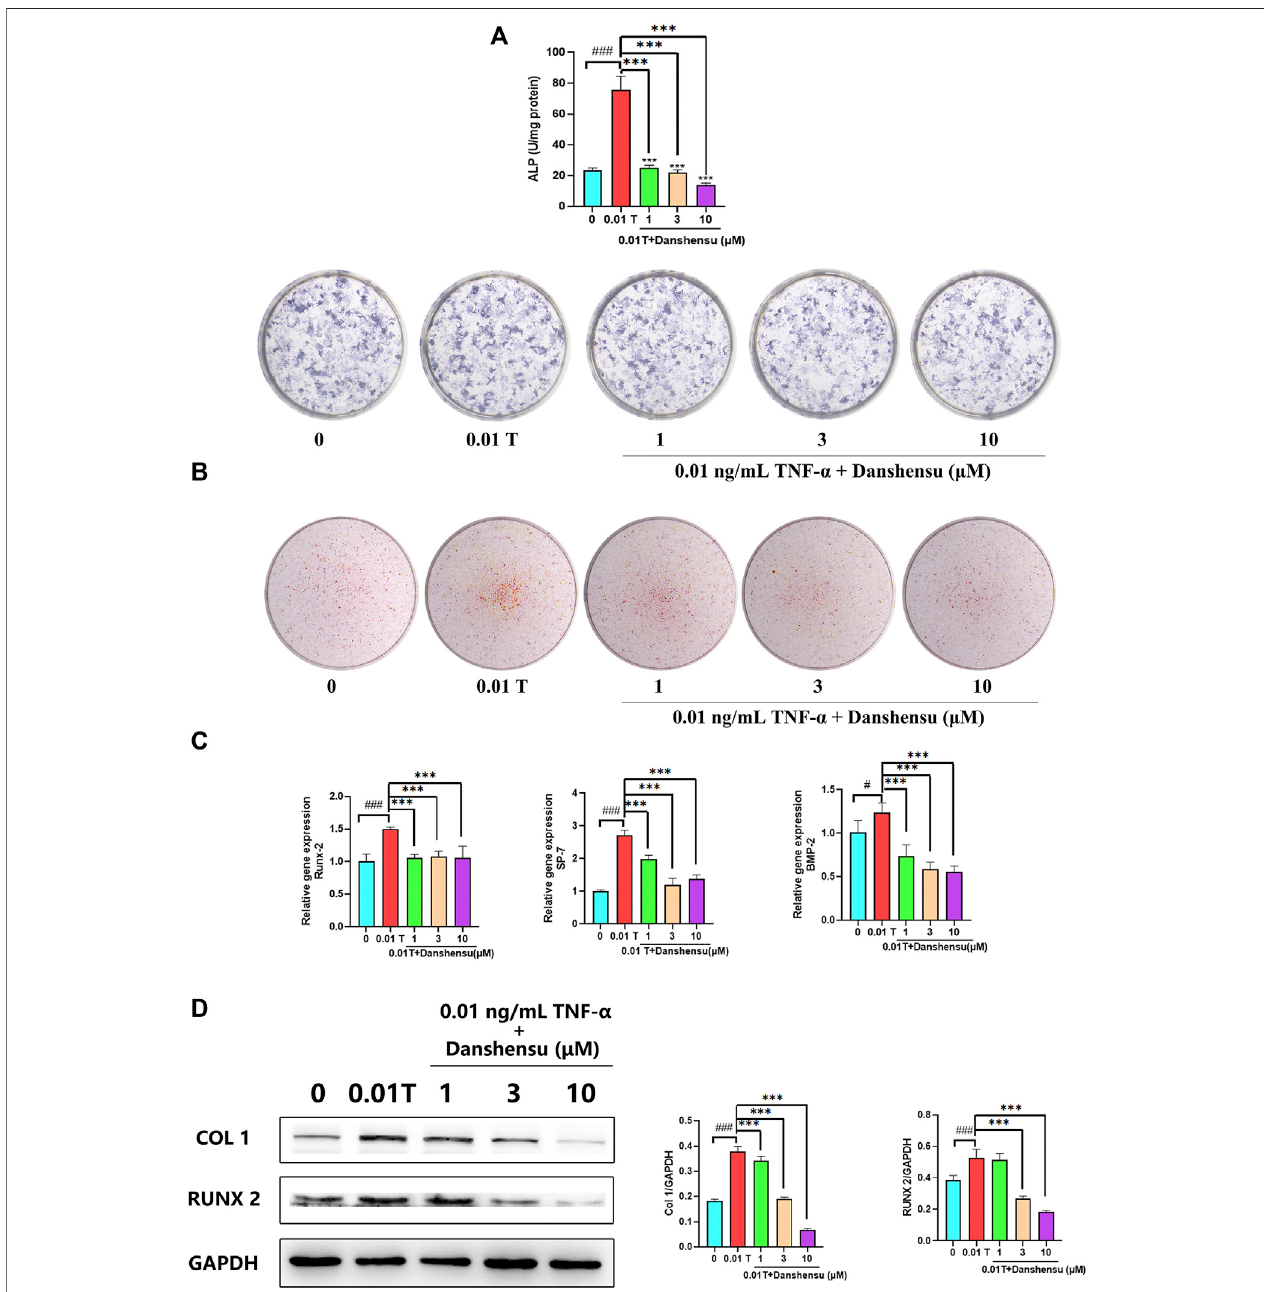
FIGURE7| DanshensuinhibitsTNF- α – inducedosteogenicdifferentiation. (A) ALPactivityandstainingofosteoblastsafter7 daysoftreatmentwithTNF- α . (B) ARS of osteoblasts at days 30. (C) SP7 , BMP2 , and RUNX2 mRNA expression in osteoblasts on day 14. (D) RUNX2 and COL1 protein levels on day 14. # p < 0.05, ### p < 0.01 vs. 0 group; * p < 0.05, ** p < 0.01, *** p < 0.001 vs. 0.01 T group, n (cid:2) 3.